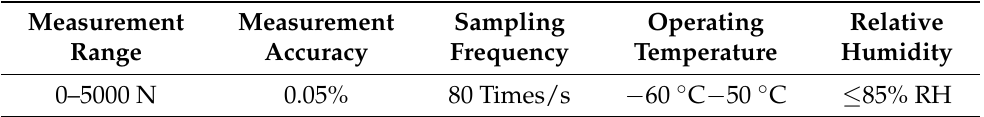
Table 1. Related technical parameters of load